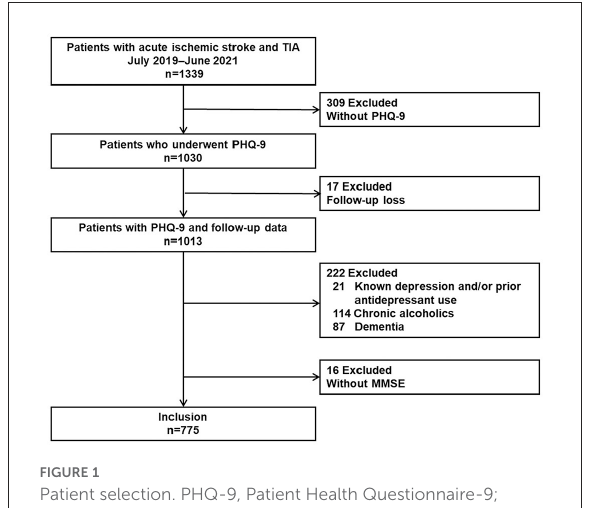
FIGURE1 Patient selection. PHQ-9, Patient Health Questionnaire-9; MMSE, Mini-Mental State